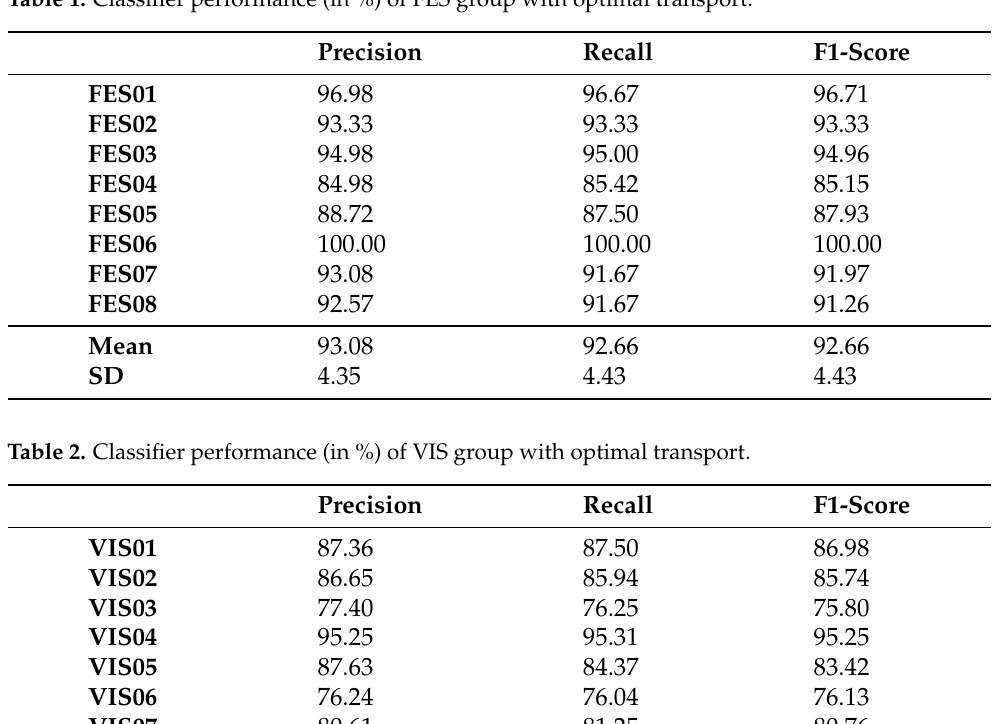
Table 1. Classifier performance (in %) of FES group with optimal transport.